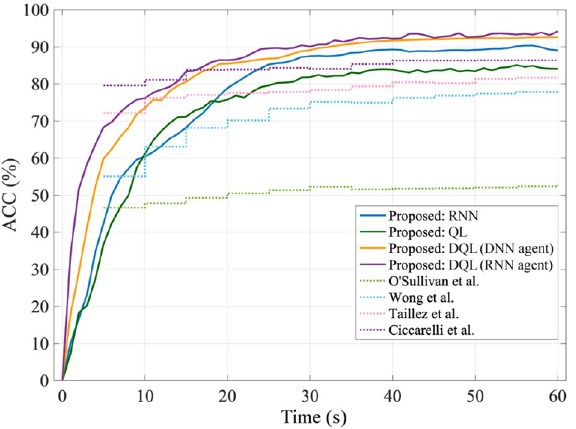
Figure 6. The comparison of the proposed SAAD and baseline methods in terms of ACC for sequentially increasing data duration.